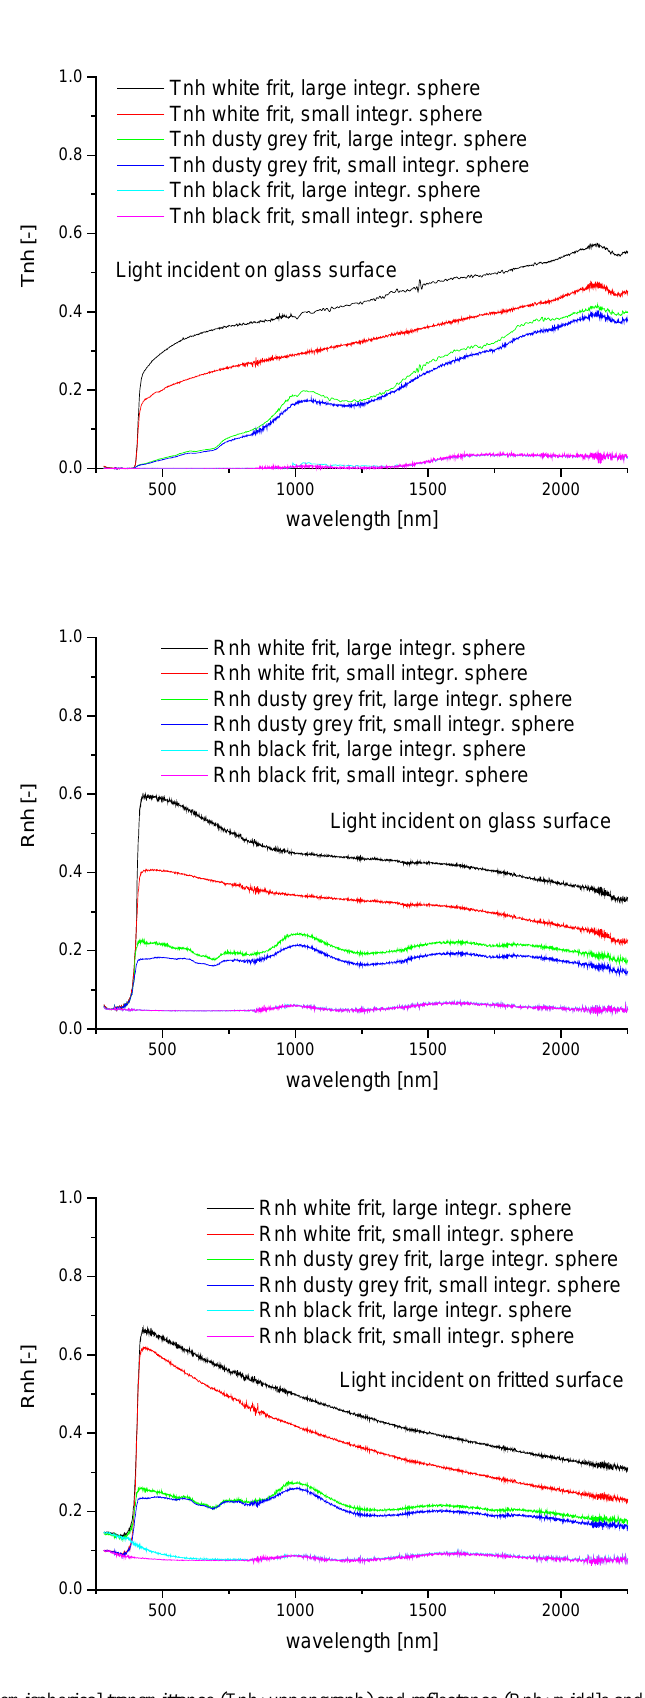
Fig. 4 Spectra for normal-hemispherical transmittance (Tnh; upper graph) and reflectance (Rnh; middle and lower graphs) for 6 mm low-iron glass panes screen-printed with white, dusty-grey and black frits, measured using integrating spheres of diameter 220 mm (small) and 620 mm (large). The measurement results obtained with the “small” integrating sphere are clearly too low in the cases of the white and grey fritted glass. In the case of the black fritted pane, the results obtained with the two spheres are almost